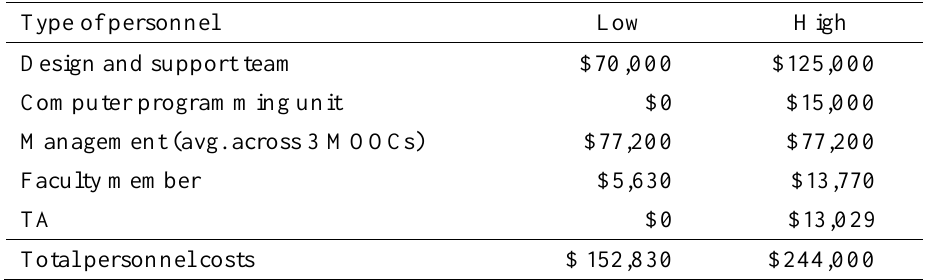
Range Of Estimated Personnel Costs Per MOOC for Design, Production, and Delivery at a Large Midwestern University Type of